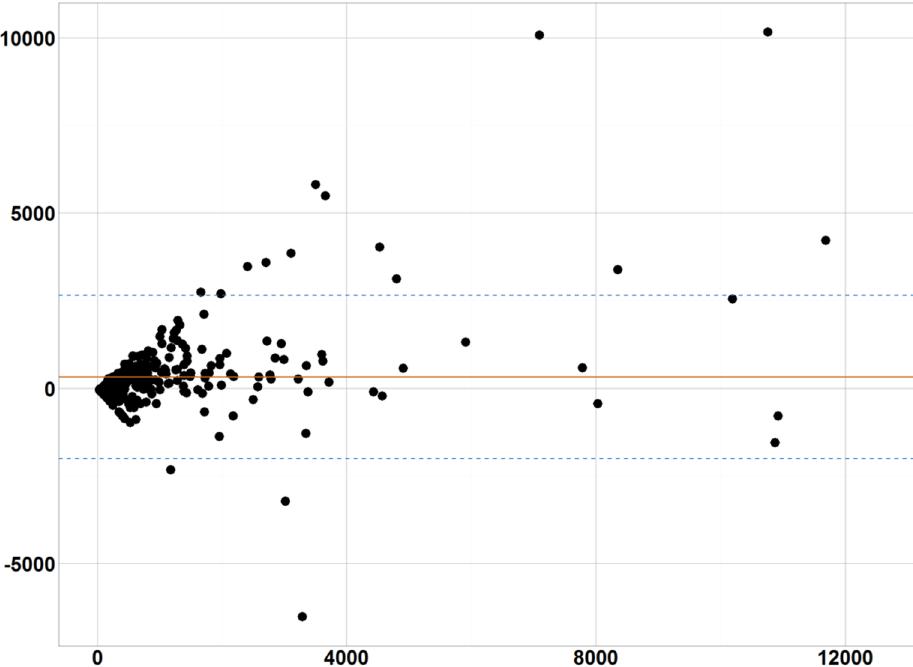
Fig 3. Bland-Altman plots. Bland-Altman plots highlightsthe differences between V nodules. The 95% intervalof the differences are depicted by the blue dotted lines. Solid red line is the average difference between V and V (= CIP manual